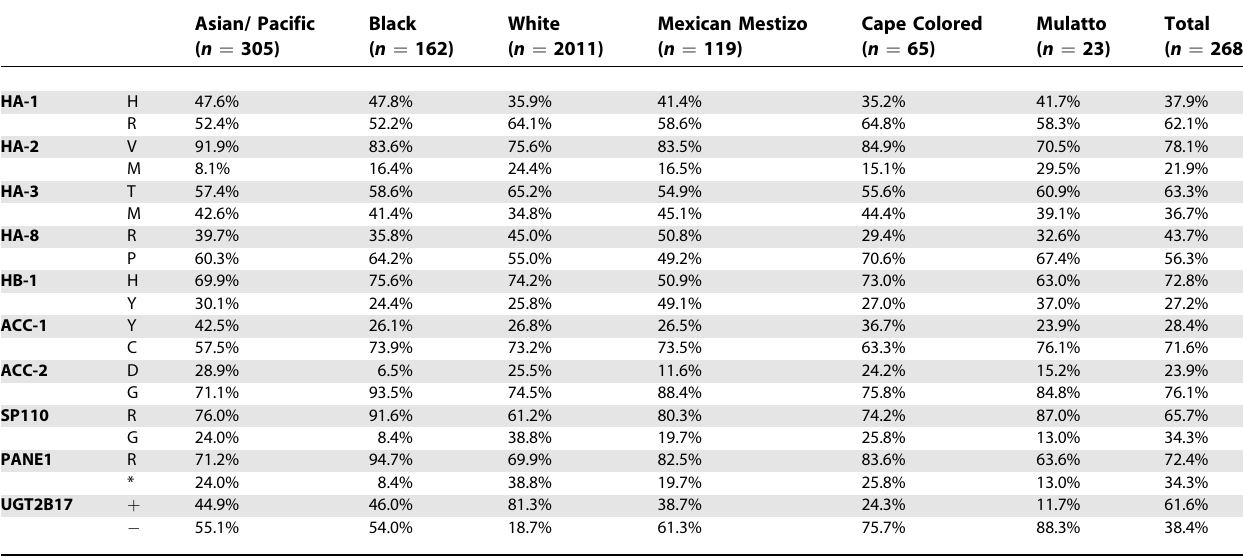
Table 2. Frequencies of the Alleles of Ten Autosomally Encoded Minor H Antigens in Six Different Ethnic Populations Asian/ Pacific ( n ¼